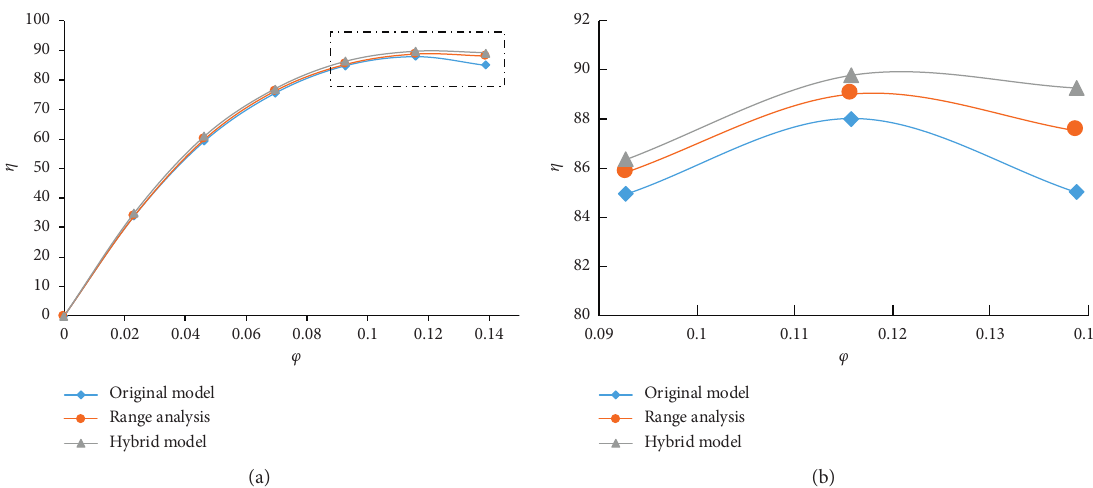
Figure 15: Comparison of high-efficiency zone before and after optimization.